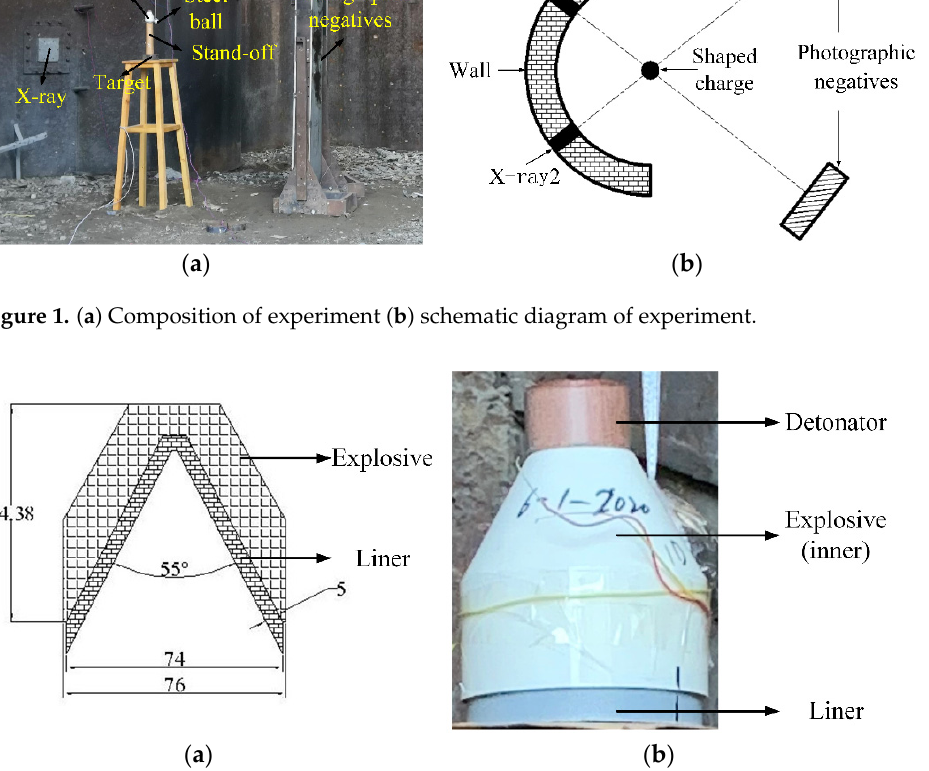
Figure 1. ( a ) Composition of experiment ( b ) schematic diagram of experiment.